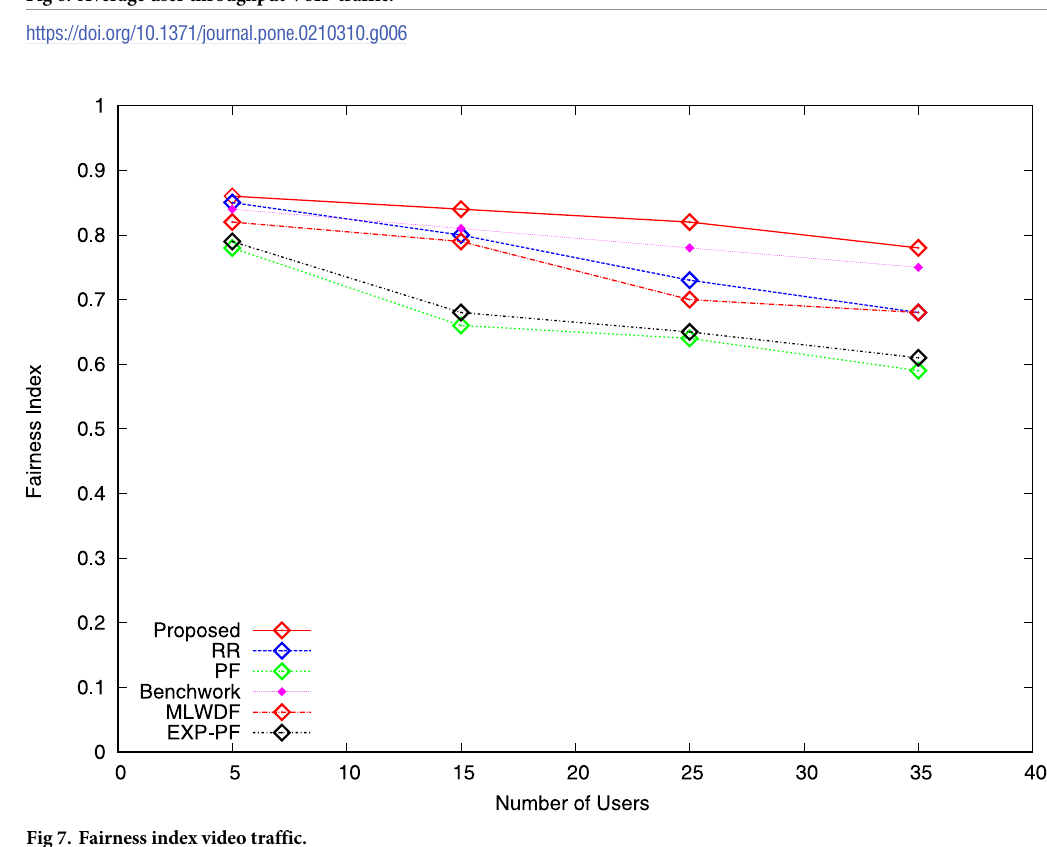
Fig 6. Average user throughput VoIP traffic.